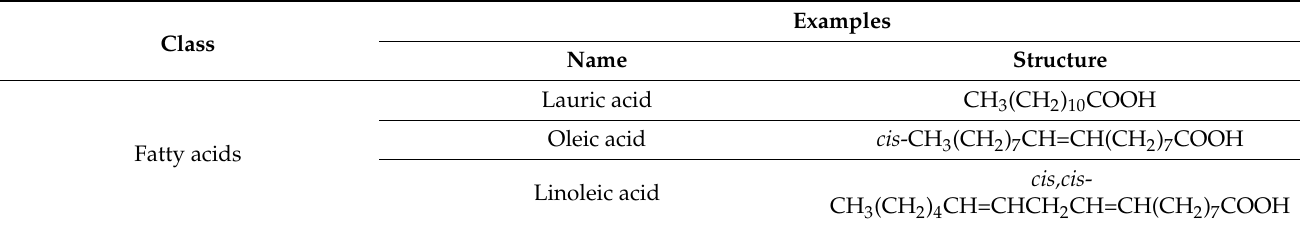
Table 1. Examples of amphiphilic chemical permeation enhancers